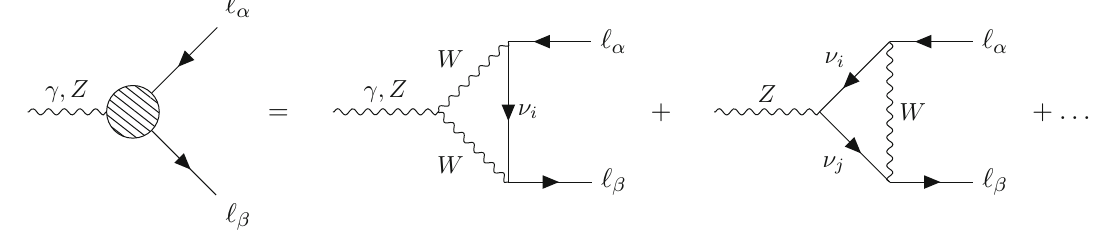
Fig. 1 Vertex diagrams contributing the cLFV decays. The flavour of the charged leptons is denoted by α,β,... = e ,μ,τ ; in the neutral fermion internal lines, i , j = 1 ,..., 3 + n S denote the neutral fermion mass eigenstates